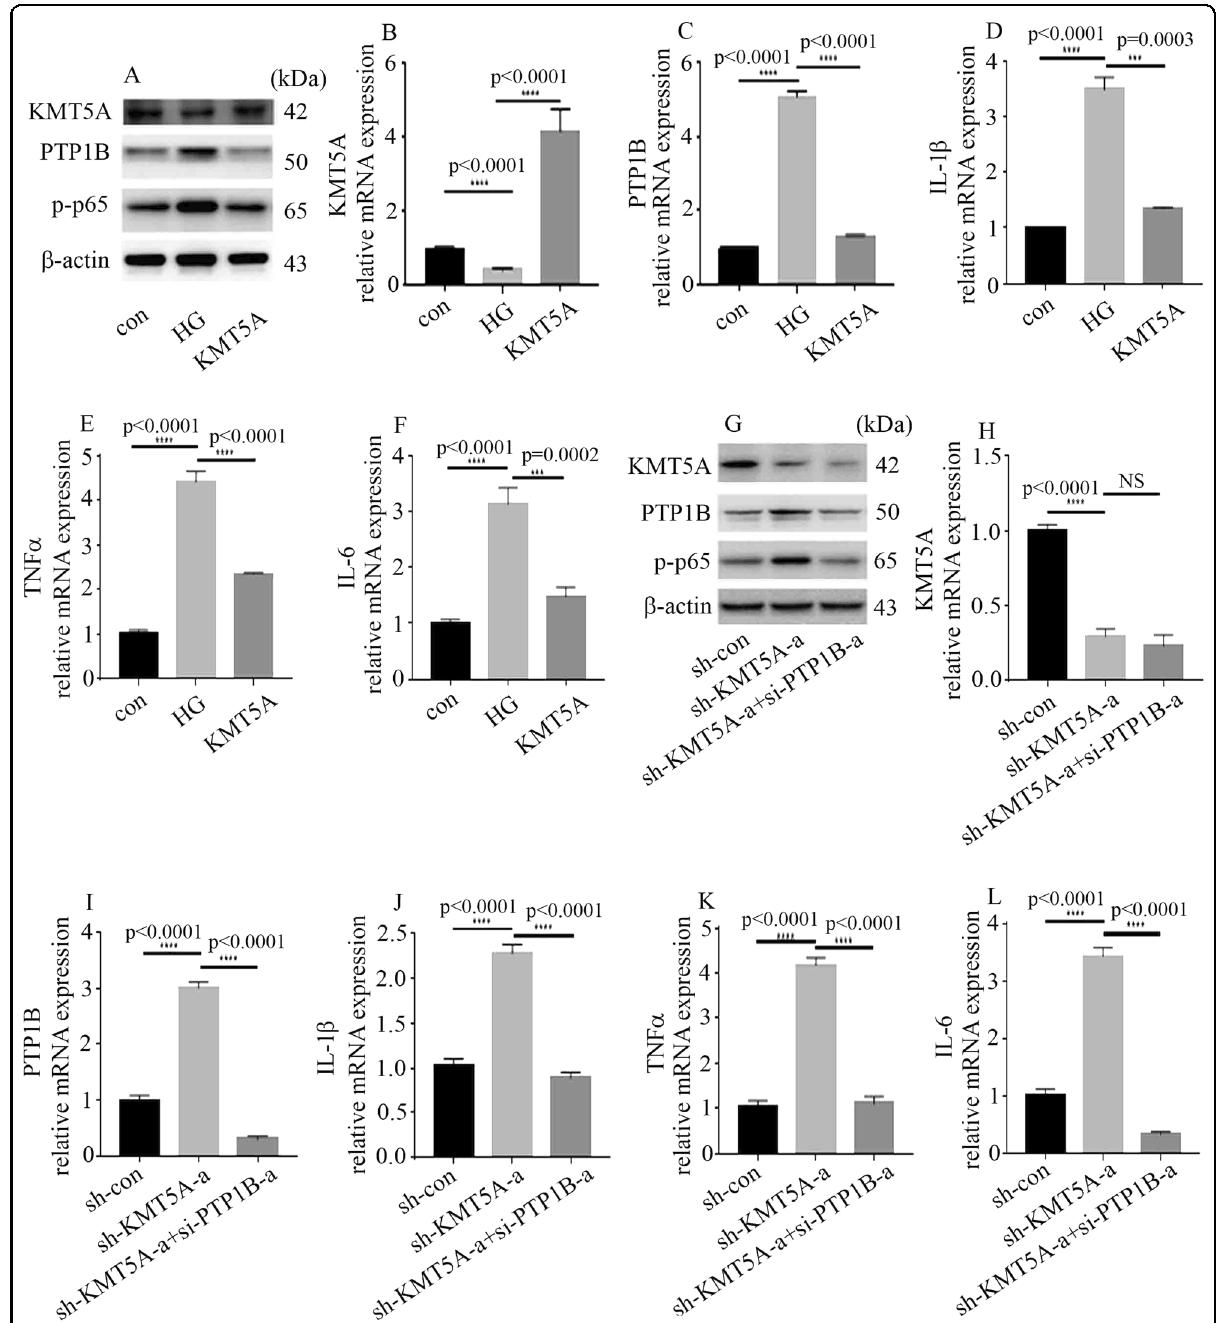
Fig. 5 KMT5A suppression participates in high glucose-mediated endothelial in fl ammation by augmenting PTP1B expression in endothelial cells. A Western blot analysis of KMT5A, PTP1B and p-p65 levels in HUVECs. B – F qPCR analysis of mRNA expression of KMT5A, PTP1B, IL-1 β , TNF α , and IL-6. G Western blot analysis of KMT5A, PTP1B and p-p65 levels in HUVECs. H – L qPCR analysis of mRNA expression of KMT5A, PTP1B, IL-1 β , TNF α , and IL-6. (* p < 0.05, ** p < 0.01, *** p < 0.001, **** p < 0.0001, n =